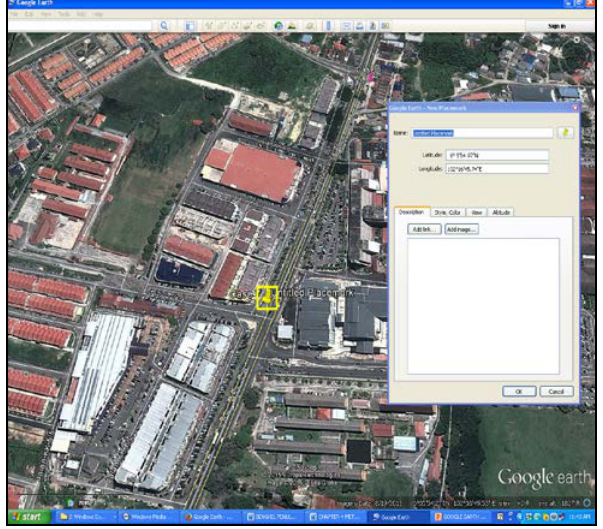
Figure 3. Mapping of RTI case by using Google earth